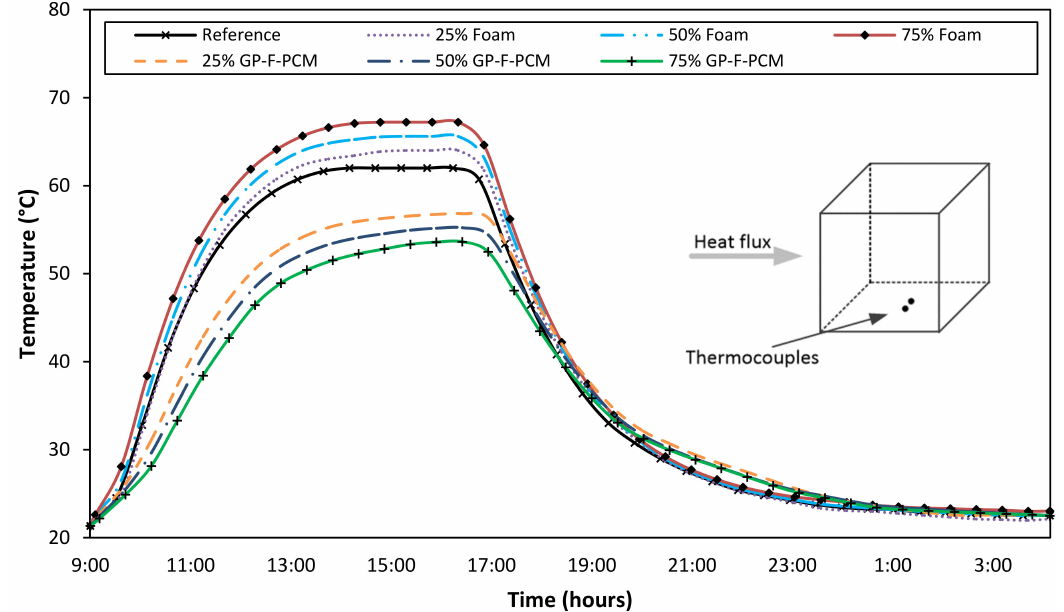
Figure 8. Comparison of temperature variations at one side of all the cubes.